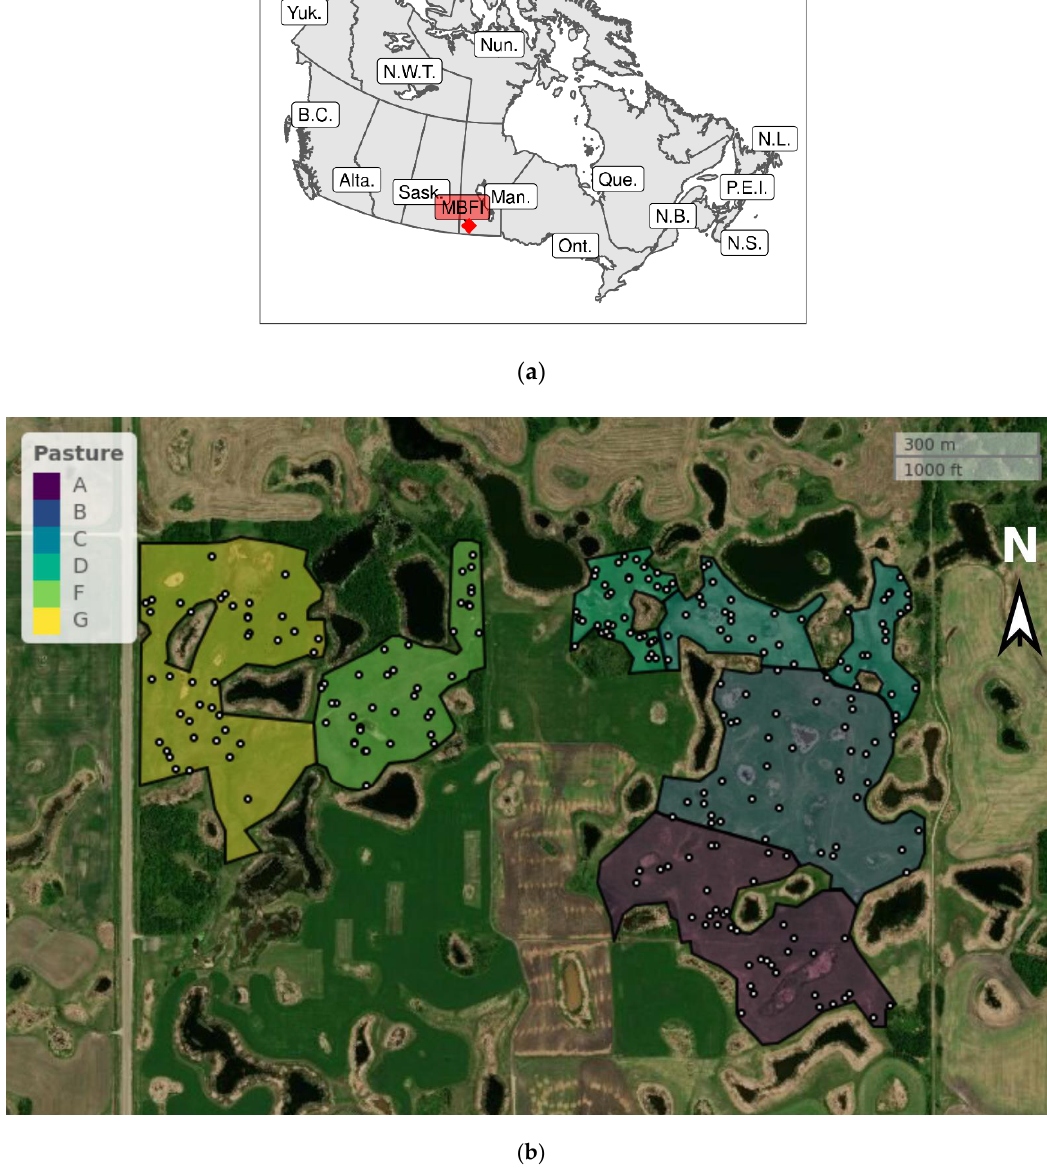
Figure 1. ( a ) Regional context and ( b ) Pastures A–G at the field site. For ( a ), the site location is marked as Manitoba Beef and Forage Initiatives (MBFI) within Manitoba (Man.), with abbreviations given for other provinces and territories in Canada. For ( b ), dark areas are prairie potholes with permanent water. Each sample point is indicated as a white circle with a dark ring. North is shown as the arrow to N. Scale is shown to the uppermost right.